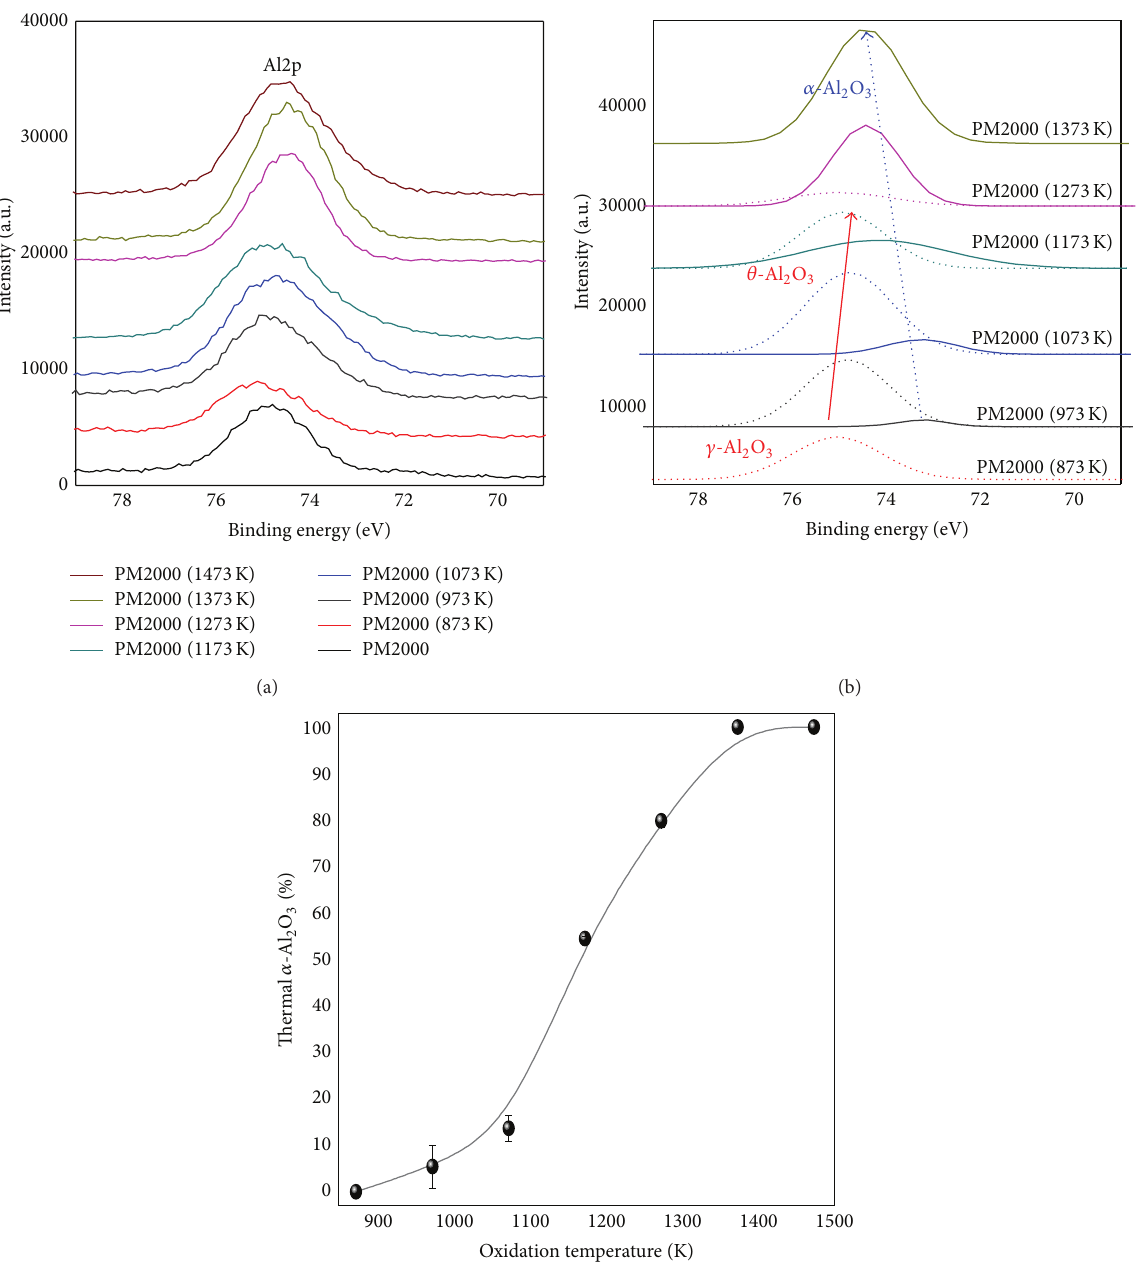
Figure9:Al2pXPSspectraofthetreatedandas-receivedPM2000(a)andAl2pXPSdecomposedspectraofPM2000(b)evolutionpercentage of the thermal 𝛼 -Al 2 O 3 phase between 873 and 1473 K